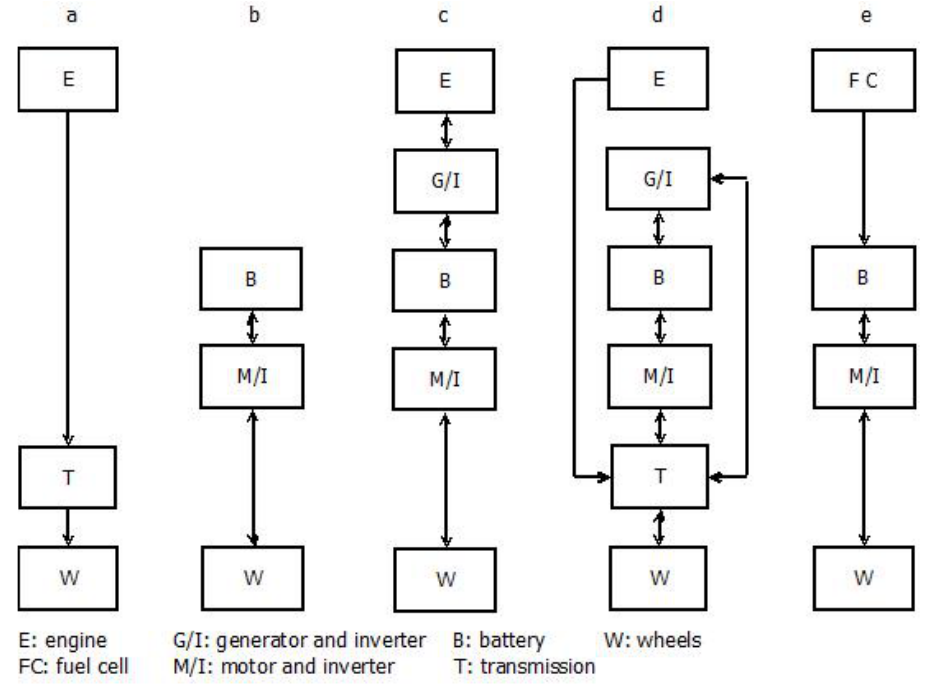
Figure 2. Diagram of the energy flows in different types of vehicle configurations: ( a ) CV; ( b ) battery EV; ( c ) series HEV; ( d ) power-split HEV, and ( e )